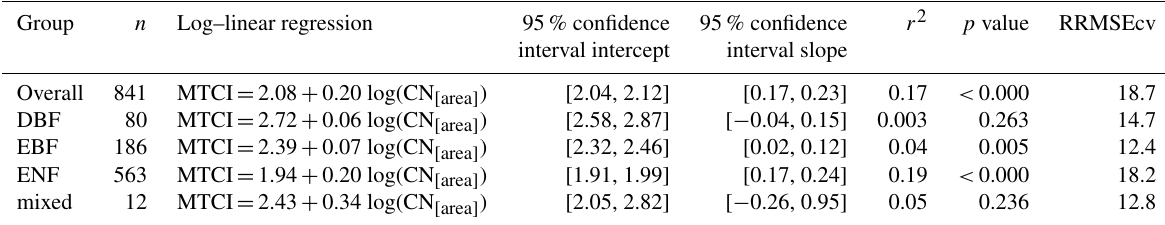
Table 4. Observed log–linear regressions equations between the MTCI (–) and canopy nitrogen content (CN [ area ] , gm − 2 ) for different subgroups. Number of plots ( n ), determination coefficient ( r 2 ) , p value and RRMSEcv are shown. PFT is plant functional type, DBF is deciduous broadleaf forest, EBF is evergreen broadleaf forest, ENF is evergreen needleleaf forest, and mixed is mixed